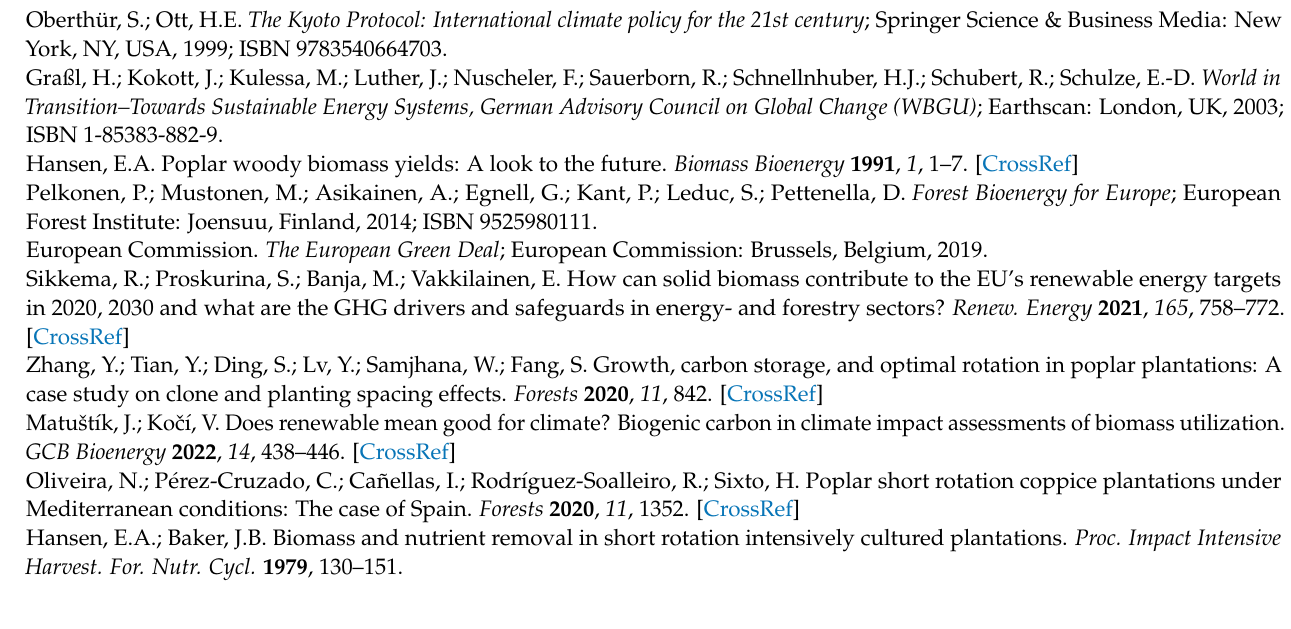
table of data; and Table S3. Yield of short-rotation crops with different planting densities and